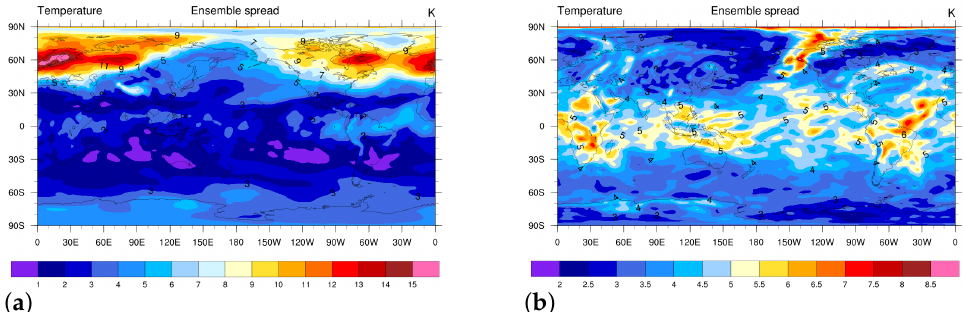
Figure 6. The initial ( a ) and the 6-h integration ( b ) ensemble spread of the randomly perturbed T.